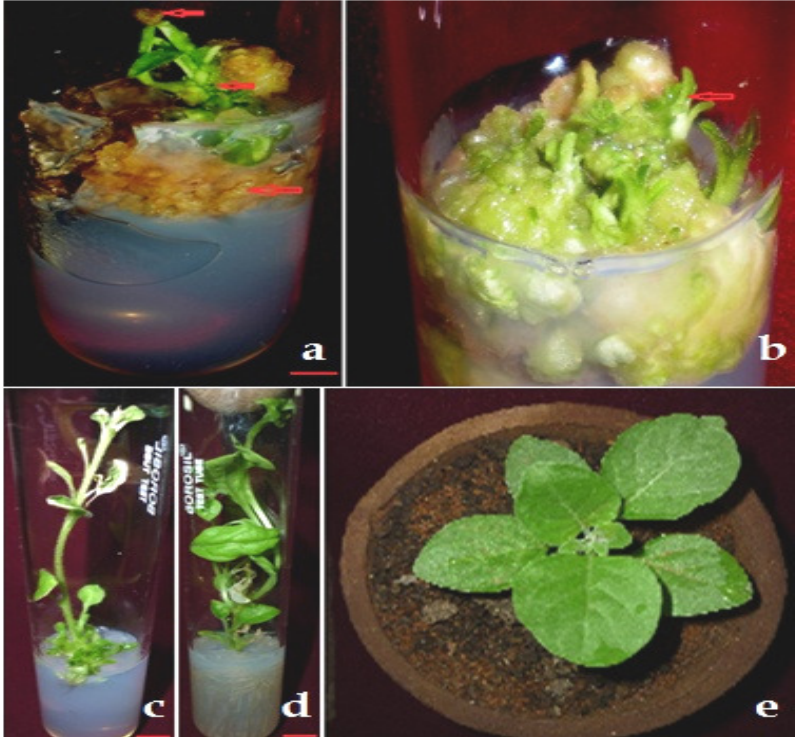
Fig. 1. In vitro plant regeneration from mature seed explants of Withania somnifera (L.) Dunal; a) multiple shoots and embryogenic callus developed from seed explant (arrows show multiple shoots, embryogenic callus and seed coat); b) Emergence of multiple shoots (arrow) from the embryogenic callus; c) Elongated shoot; d) well developed roots consisting plant; e) acclimatized plant. Scale bar length is 0.5